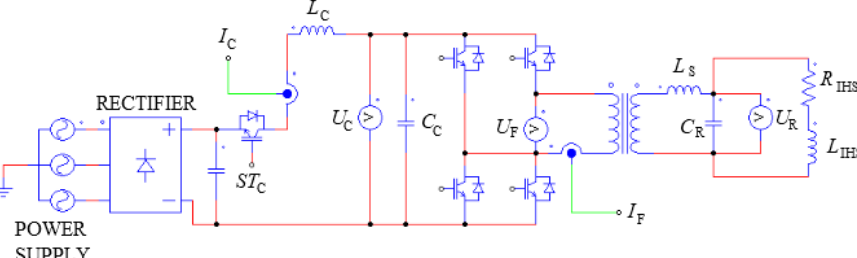
Figure 10. Simplified schematic diagram of the LLC generator system, including only one inverter